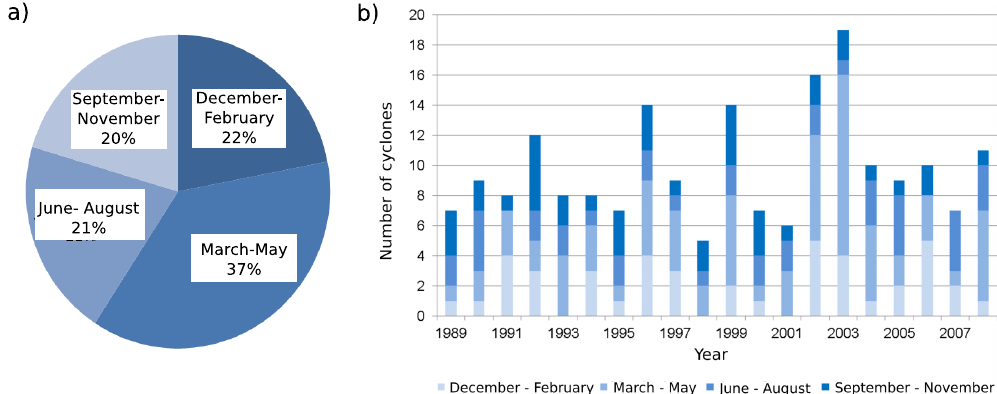
Figure 3. Seasonal and interannual variations of long-lived and migrating cyclones. (a) Seasonal distribution of cyclones and (b) time series of cyclones in the sub-domain 0–40 ◦ N and 20 ◦ W–45 ◦ E for 1989–2008.